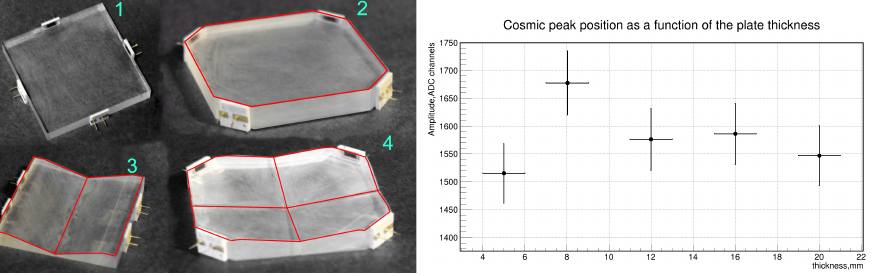
Figure 1. PMMA plates of di ff erent shapes / types (left); position of the cosmic peak for the PMMA plates of type 4 with di ff erent thicknesses